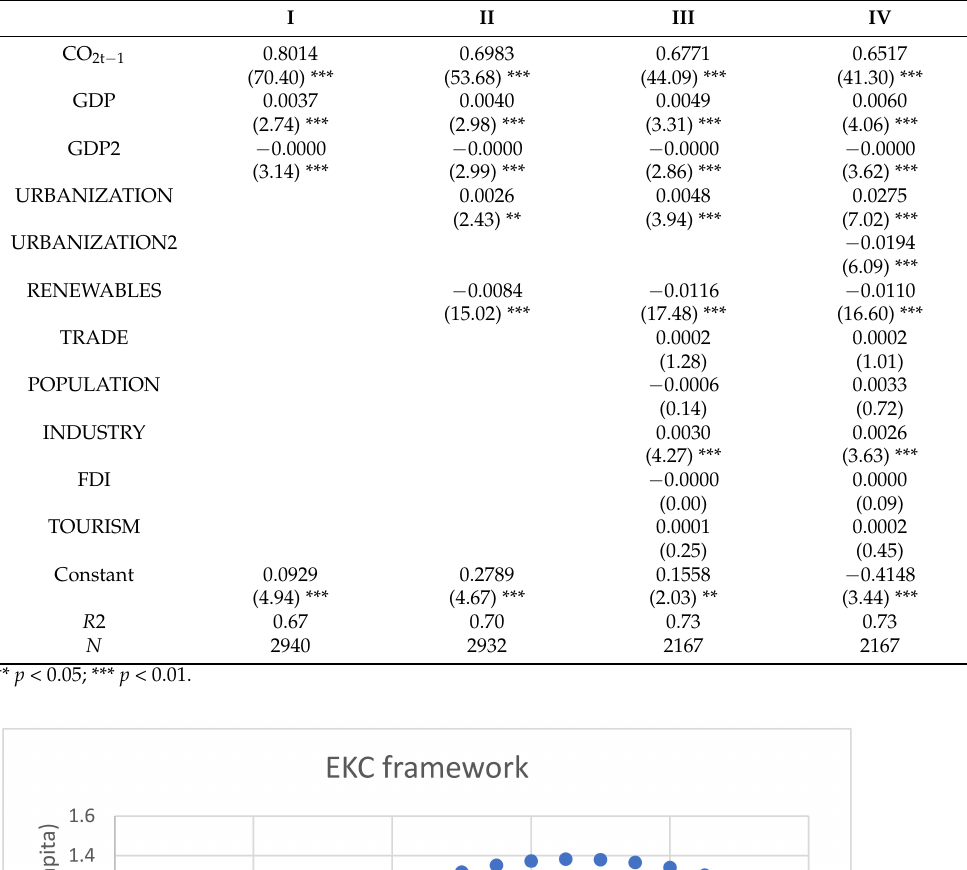
Table 2. Main results: Fixed effects regression.